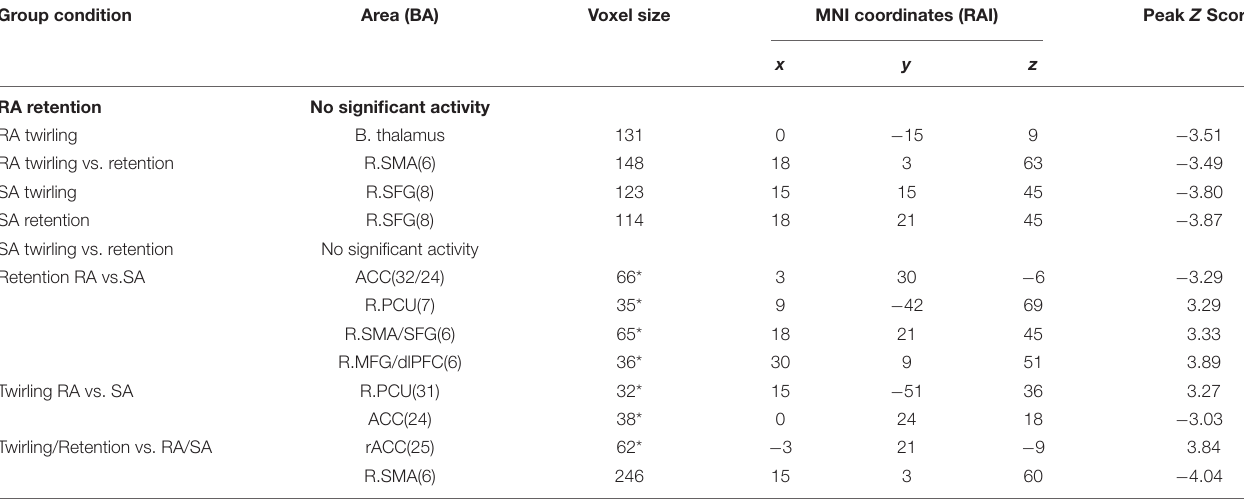
TABLE 2 | Task state-related brain activity in each group and intergroup activity differences under each condition. Group condition Area (BA) Voxel size MNI coordinates (RAI) Peak Z Score